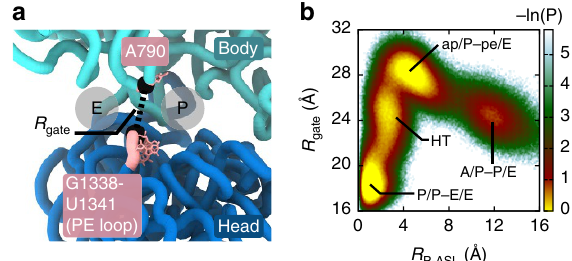
Figure 4 | Changes in steric features of the mRNA binding track are associated with tRNA movement. ( a ) The PE loop (residues G1338-U1341) in the head and residue A790 in the body (pink) form a steric gate separating the E and P sites. R gate is the distance between the P atoms of U1340 and A790 (black beads), and is used to probe opening and closing of the gate. ( b ) The probability distribution P ( R P (cid:2) ASL , R gate ) implicates a large degree of gate opening ( R gate ¼ 26–30Å) in the ap/P–pe/E ensemble, which is associated with head rotation ( f head E 18 (cid:2) , cf. Fig. 3a,b). In